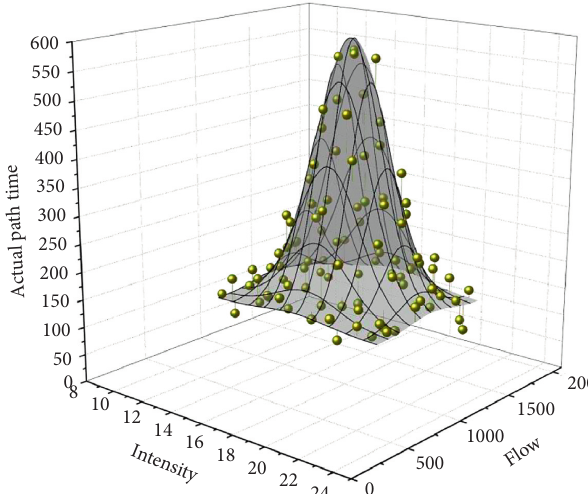
Figure 9: Graphical representation of actual path travel